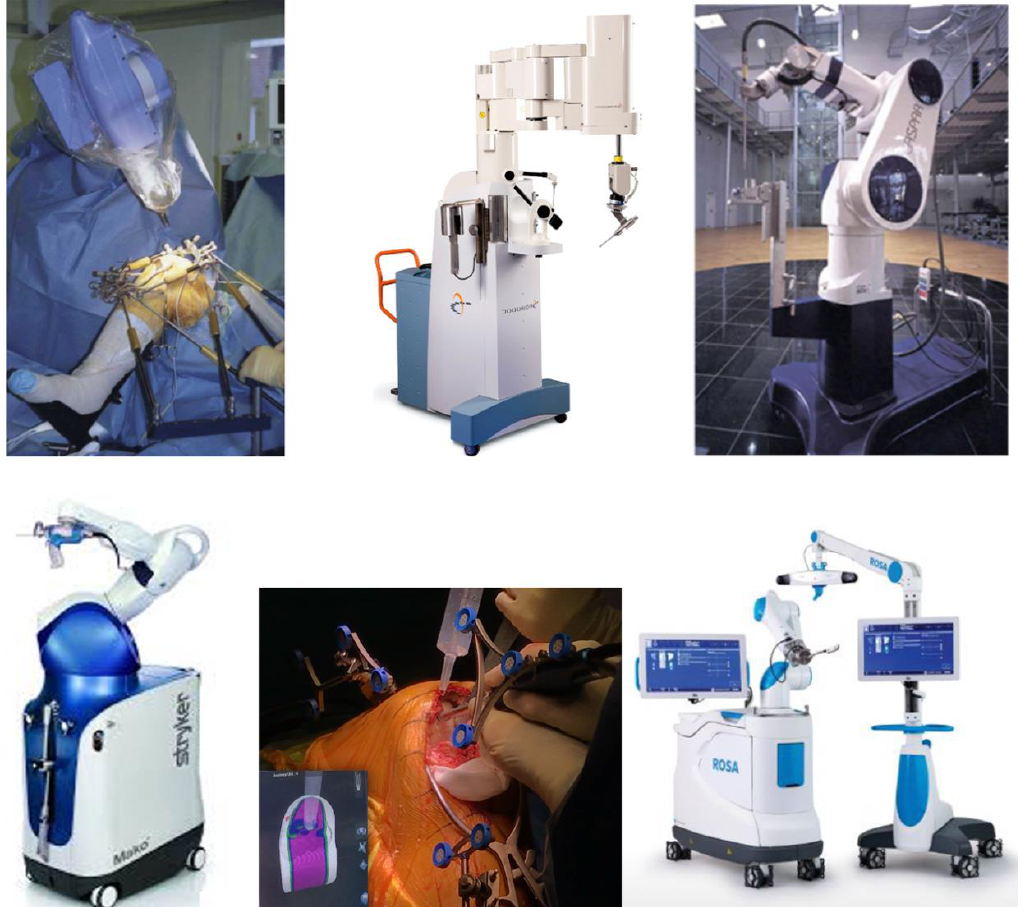
Figure 4. The autonomous and semiautonomous robotic systems incorporate safeguards against removal of bone beyond the 3D plan. The first three robotic systems are autonomous (Robodoc, Caspar). The last three robotic systems are semiautonomous (Mako, Navio, Rosa).